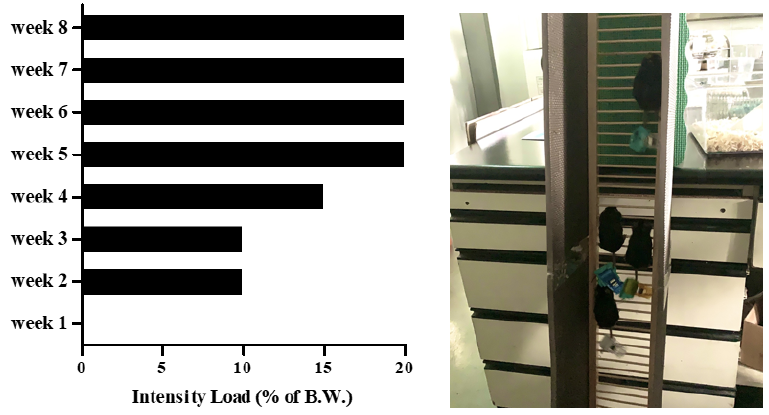
Figure 1. Experimental design. X: non-exercise, O: exercise.